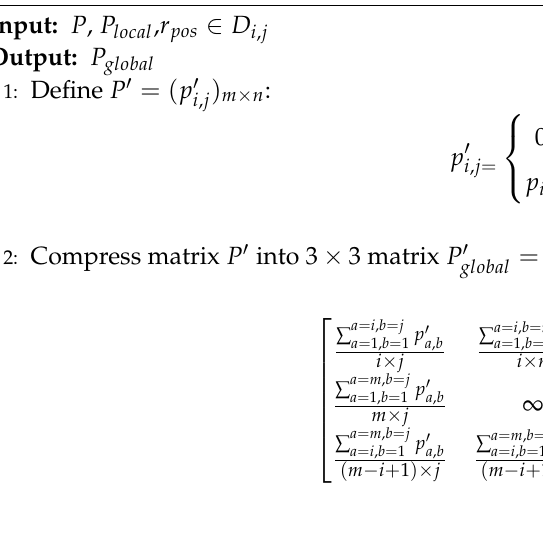
Algorithm 3 Compress P into P global